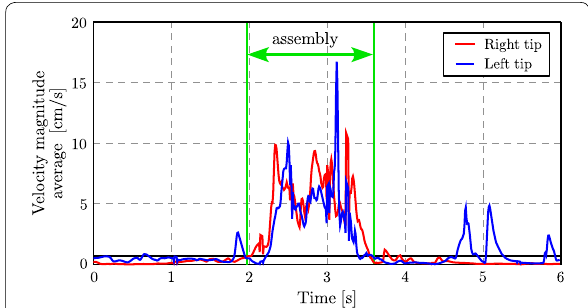
Fig. 4 Velocity magnitude average between the index and the thumb fingers’ tips throughout the recorded assembly. The horizontal solid line represents | v th | and the vertical solid lines represent the start‑ ing and ending points obtained by Eq.